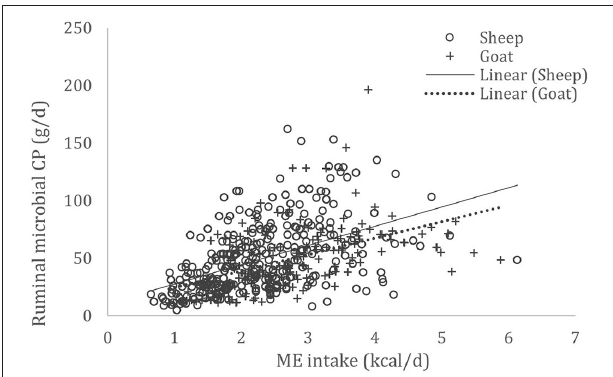
FIGURE 3 | Total databank used to establish the relationship between metabolizable energy (ME) intake (Mcal/day) and microbial crude protein (MCP—g/day) produced in the rumen of sheep and goats, made from 19 experiments ( n =